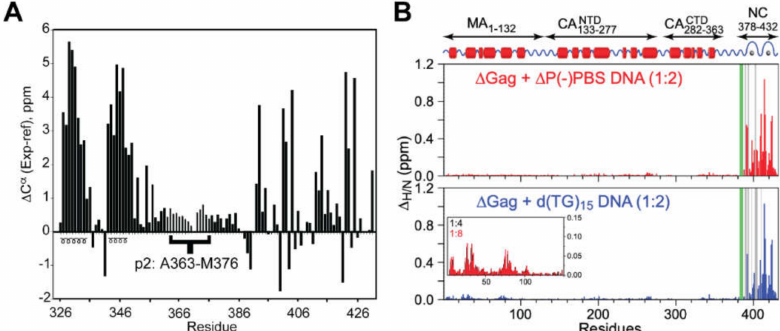
Figure 4. NMR studies of larger Gag constructs. ( A ) Plot of 13 C α chemical shift indices for SP1 (previously called p2, in braces) and adjacent residues in CA CTD -SP1-NC. Consecutive positive values are indicative of α -helical structure. ( B ) 1 H / 15 N chemical shift perturbation profiles in the presence of DNA [Red— ∆ P(-)PBS, Blue—d(TG) 15 ]. In the presence of ∆ P(-)PBS, chemical shift perturbations are only seen within the NC domain. In the presence of d(TG) 15 , significant chemical shift perturbations are present within NC but some perturbations are present in regions of MA at higher DNA concentrations (inset). Adapted from [18] (Panel A ) and [121] (Panel B ), with